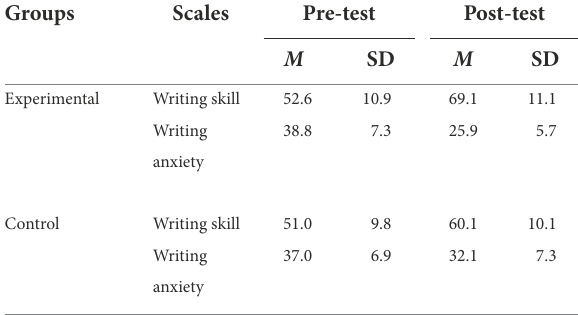
TABLE 1 Descriptive statistics of the two groups. Groups Scales